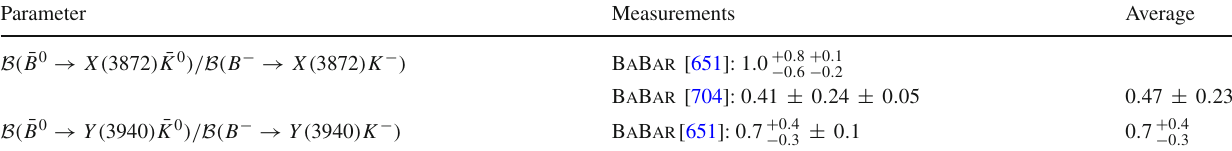
Table 134 Relative decay